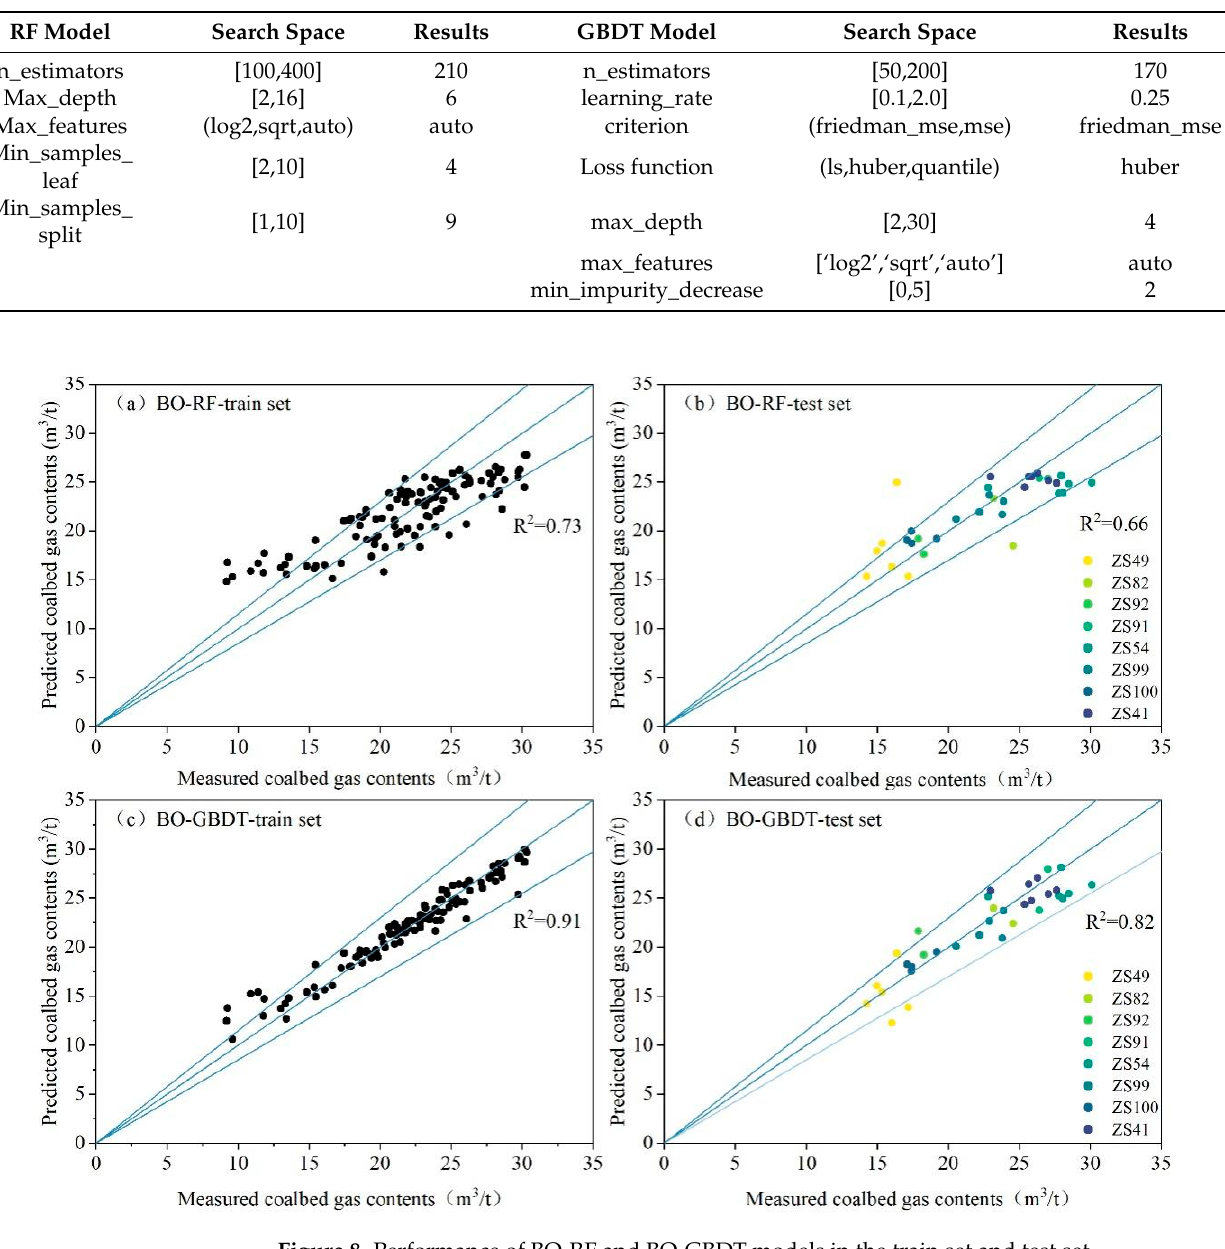
Figure 8. Performance of BO-RF and BO-GBDT models in the train set and test set. Table 3. Searching space of Bayesian hyper-parameter optimization method.